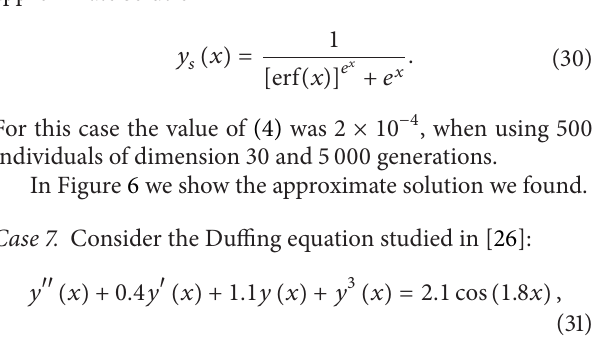
but with boundary conditions 𝑦(0.5) = 0 , 𝑦(1) = 1 .